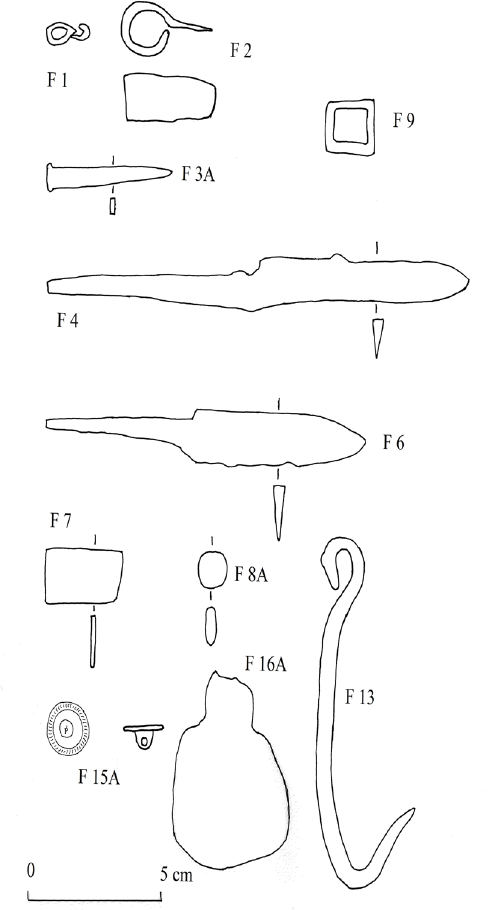
Figure 5. Selection of metal artifacts found in connec- tion with hearths on site NHB 694: F 1 iron eyelet; F 2 iron fragment; F 3A flat iron nail; F 4 and 6 iron knives; F 7 iron fragment; F 8A flattened rounded lead bullet; F 9 iron buckle; F 13 iron hook for hanging kettles; F 15A ornamental bronze button; F 16A sheet of bronze (from bronze